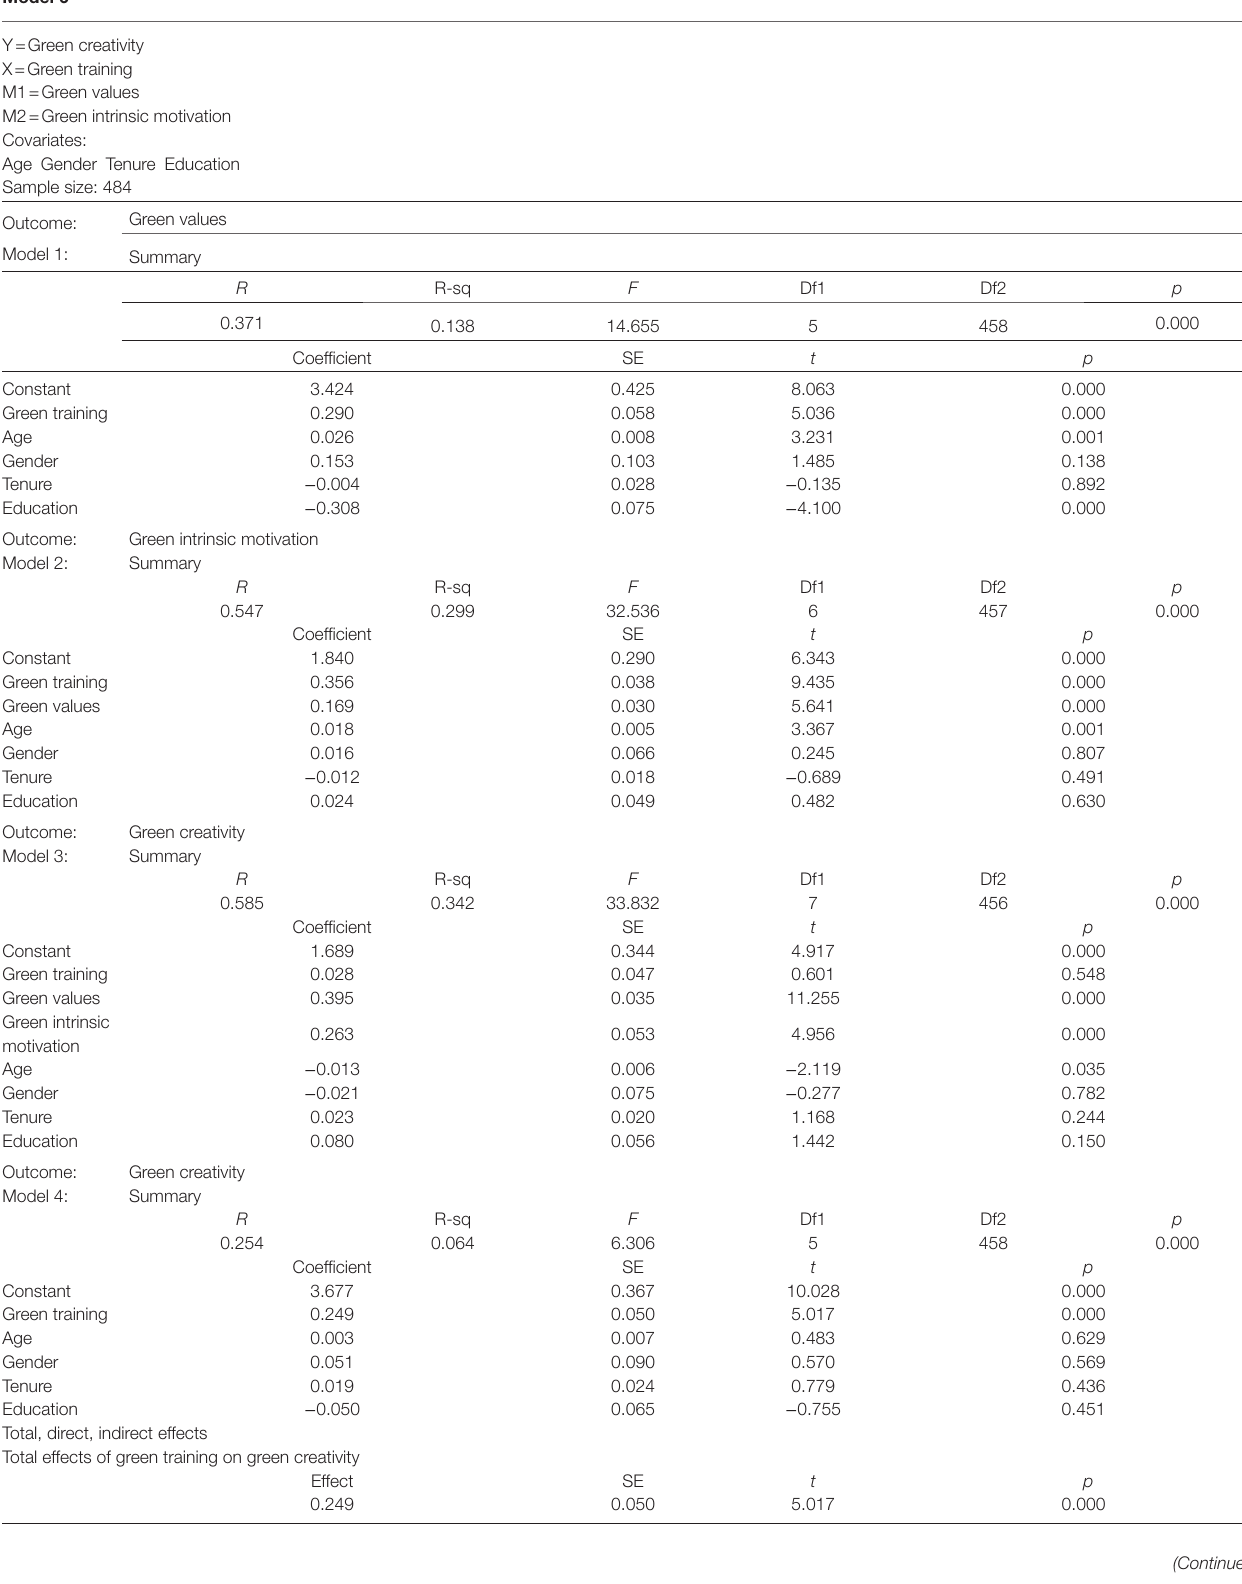
TABLE 3 | Results of sequential mediation analyses (PROCESS Model 6 in SPSS). Model